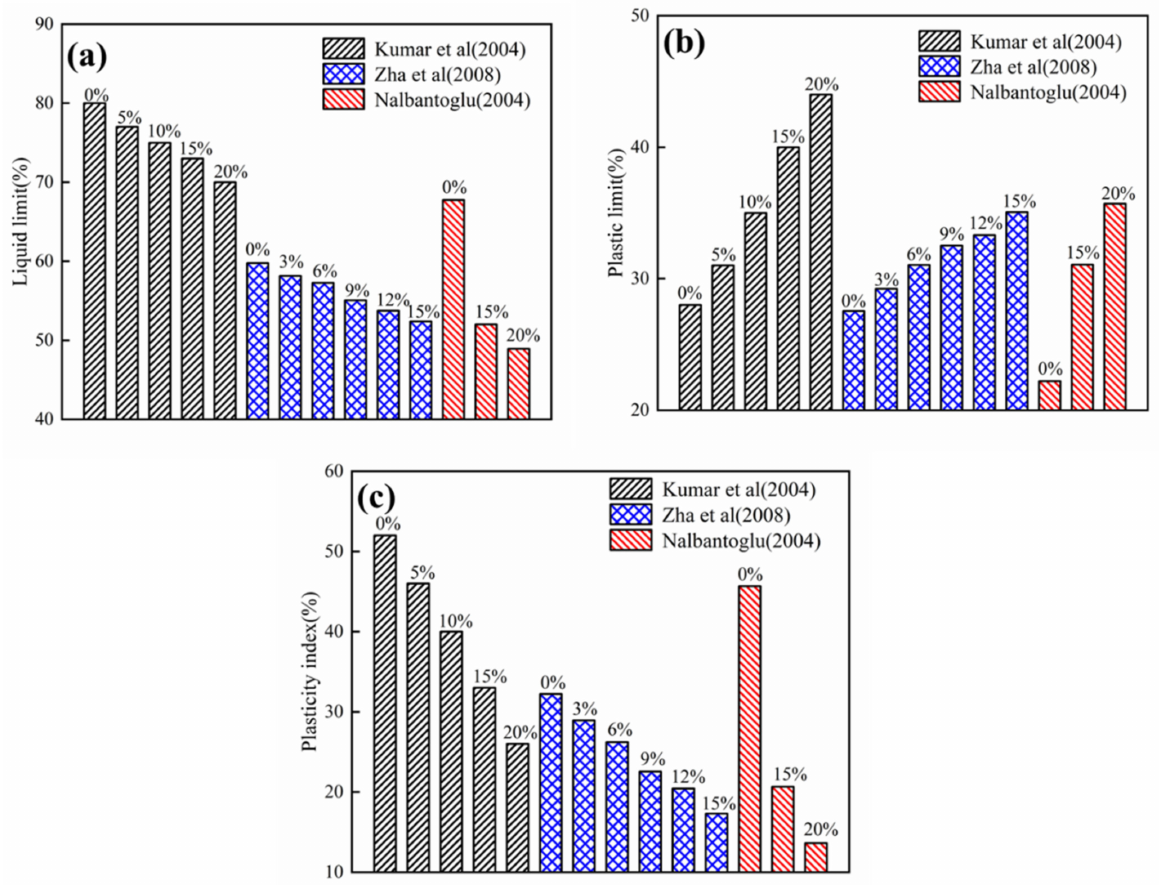
Figure 8. Effect of fly ash on the Atterberg limit of expansive soil ( a ) liquid limit; ( b ) plastic limit; ( c ) plastic index. Adapted from